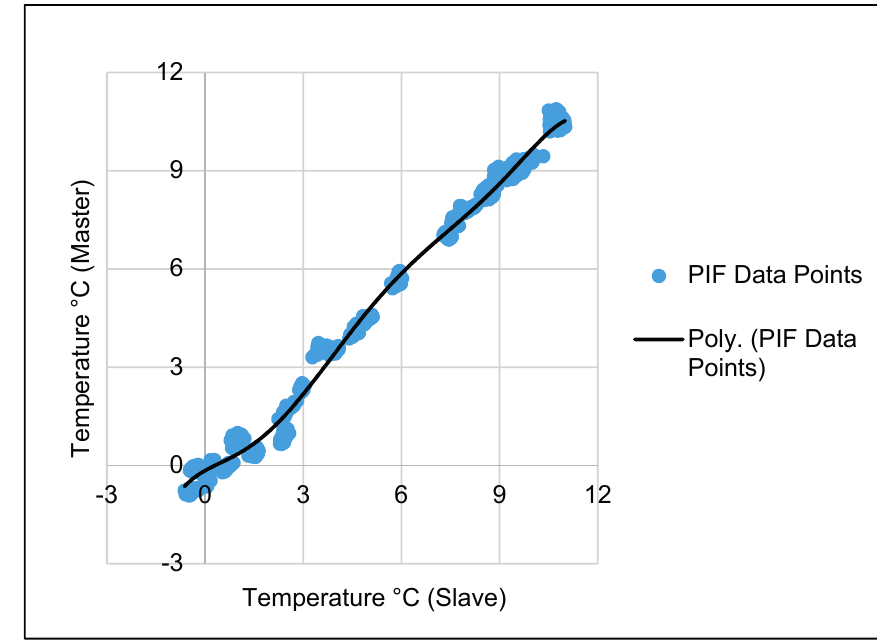
Figure 3. A scatterplot of pseudo-invariant features (PIFs) selected within the overlap of the master and the slave images. These PIFs represent a combination of four land cover classes (grass, river water, rooftop and road) and are shown modeled with a sixth order polynomial trend line (black). Poly,